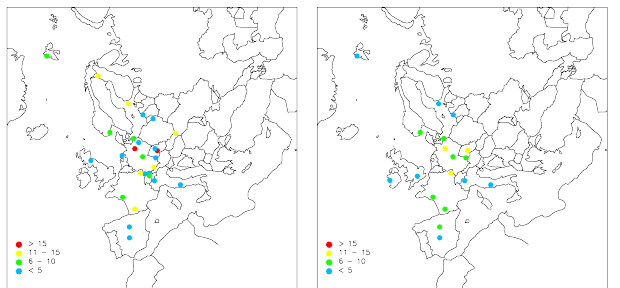
Fig. 10. Number of years with EMEP monitoring data during 1990– 2009 for light hydrocarbons (left) and carbonyl compounds (right).